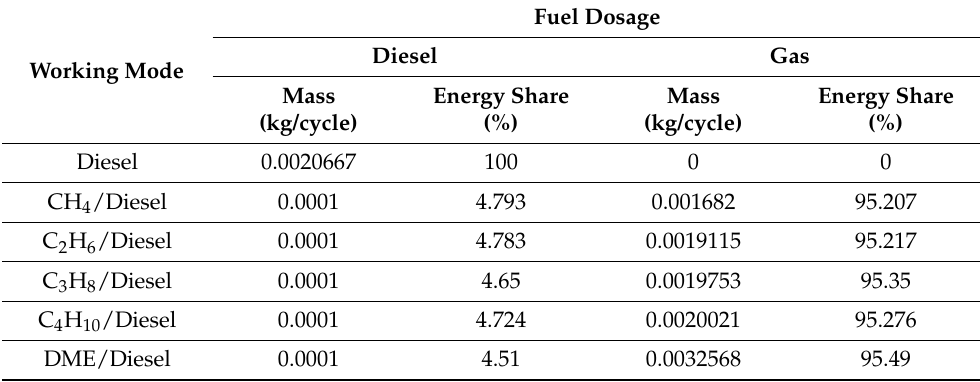
Table 4. Fuel dosage and energy share of diesel pilot fuel in the total fuel dosage.